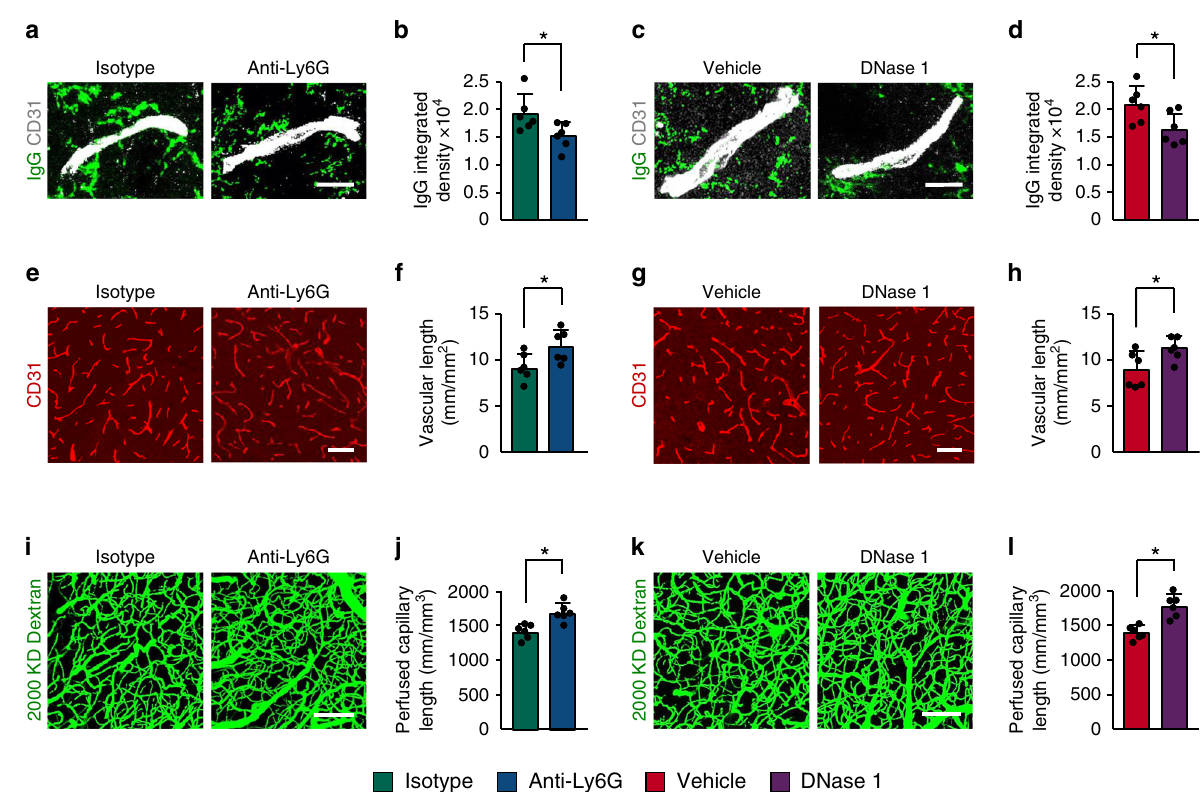
Fig. 5 Increased vascular remodeling by delayed inhibition of NET formation. a – d Representative confocal images ( a , c ) and quantitative analysis of IgG extravascular deposits ( b , d ) in the peri-infarct cortex at 14 days. Mice were subjected to stroke and treated with either anti-Ly6G antibody, control antibody, DNase 1, or vehicle starting at 7 days ( n = 6), unpaired two-tailed Student ’ s t -test was applied with * P = 0.0392 ( b ), * P = 0.0384 ( d ). Bar = 10 μ m. e – l Representative confocal images ( e , g ) of CD31-positive microvessels and in-vivo multiphoton microscopy images of perfused cortical capillaries with intravenously injected FITC-dextran ( i , k ) in the peri-infarct cortex at 14 days in mice treated with either anti-Ly6G antibody, control antibody, DNase 1, or vehicle. Bar = 40 μ m ( e , g ) and 100 µ m ( i , k ). Quanti fi cation of microvascular density ( f , h ) and perfused capillary length ( j , l ) for each group ( n = 6), unpaired two-tailed Student ’ s t -test was applied with * P = 0.00378 ( f ), * P = 0.0364 ( h ), * P = 0.0026 ( j ), * P = 0.0006 ( l ). Data are presented as mean ± SD. Source data underlying graph b , d , f , h , j , and l are provided as a Source Data fi